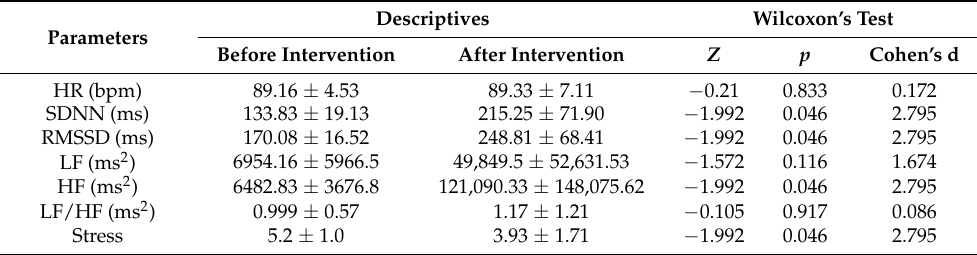
Table 2. Participant 1 statistics and contrast for HRV-related